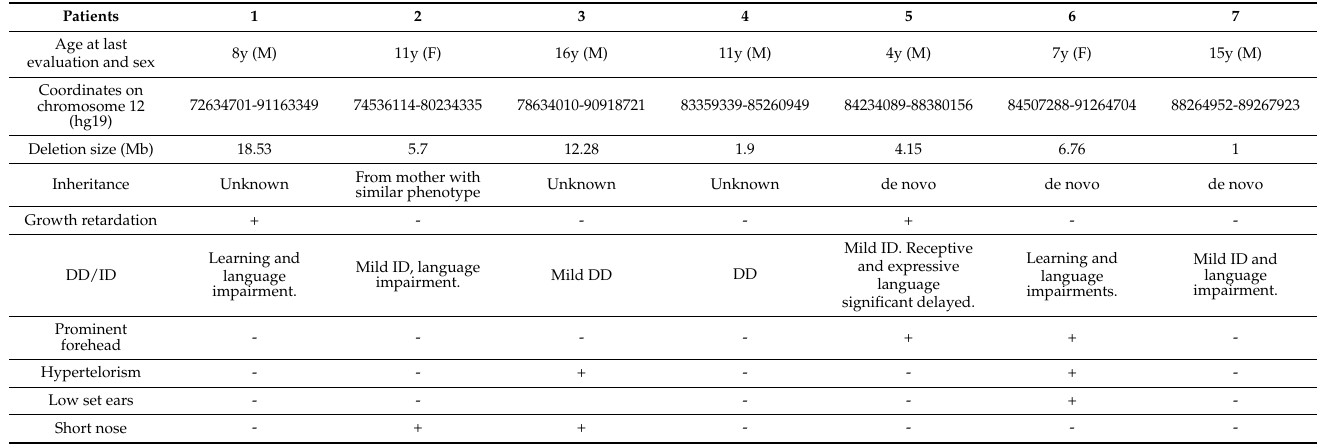
Figure 2. Molecular cytogenetic analyses: array-CGH profile of chromosome 12 of Patients 1 ( A ), 3 ( C ), 4 ( D ) and 6 ( E ); FISH of Patient 2 with probe RP11-148D15 ( B ); the big and the small arrows point, respectively, to the deleted and the normal chromosomes 12. Table 1. Clinical and molecular cytogenetics data of 12q21 deleted patients described in the present work.